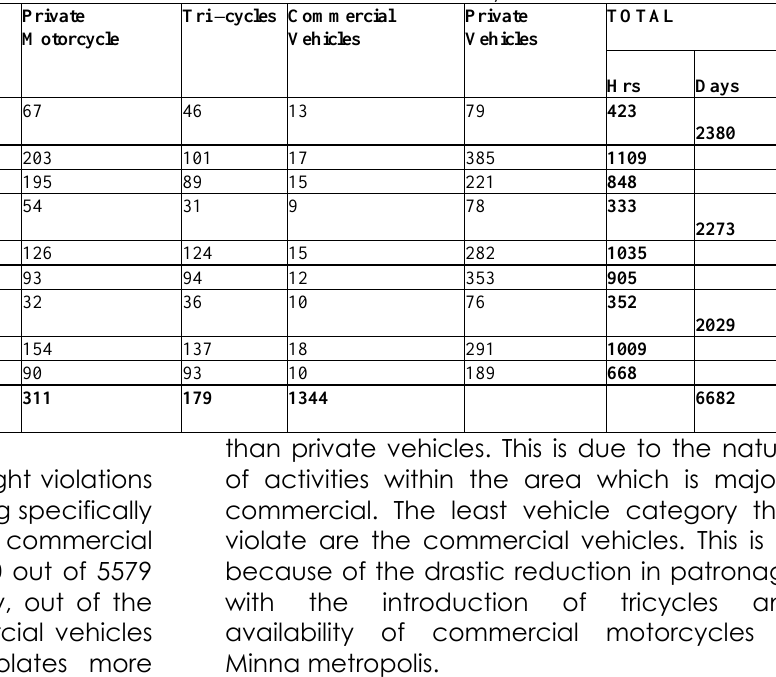
Table 3. Red Light Running Along Obasanjo Complex Road, Minna. Source: Medayese et al., 2016 Vehicle DAYS